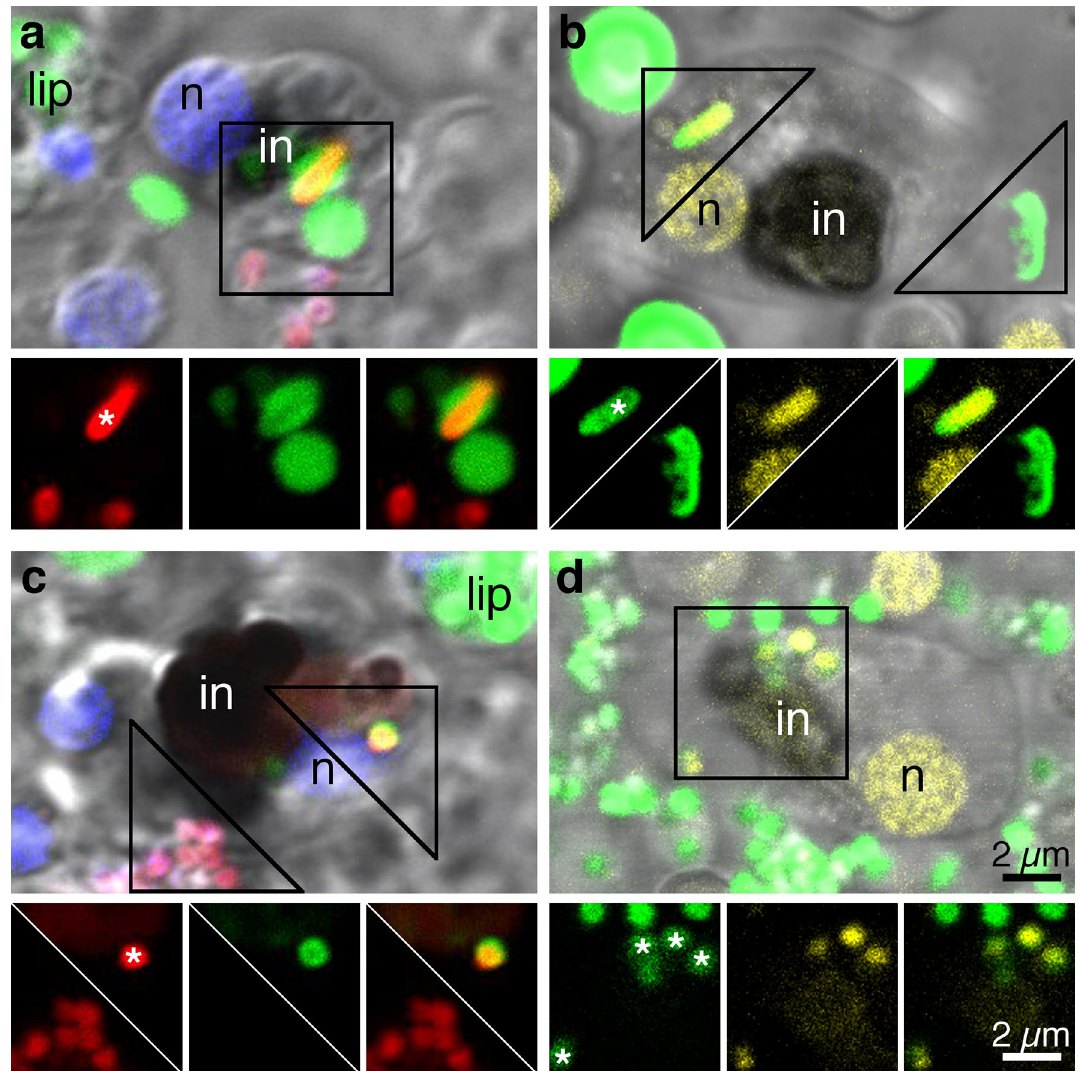
Figure 4. Uptake of bacteria by dissociated fiber cells. Merged DIC and fluorescence images. Trichoplax cells challenged with fluorescent Gram negative ( a , b ) or Gram positive ( c , d ) bacterial bioparticles. ( a , c ) Bacteria of both types (red) appear inside round 1–2 µm organelles labelled with lysotracker (green) in fiber cells. ( b , d) Bacteria of both types (green) located inside fiber cells demonstrate DHE labelling, indicating oxidation by ROS in the cell interior. Insets, below, correspond to the framed regions and show fluorescent channels separately and merged. Note co-localization of bacterial fluorescence and vital dye staining associated with phagocytosed bioparticles (asterisk) of both types and the absence of vital dye staining in bioparticles (no asterisk) located outside of fiber cells. Blue labelling in ( a ) and ( c ) is Hoechst nuclear stain. in fiber cell inclusion; lip lipophil granules labelled with Lysotracker; n fiber cell